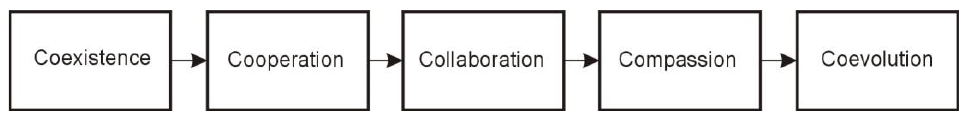
Figure 4. Human – machine 5C relationship model [44]. Figure 4. Human–machine 5C relationship model